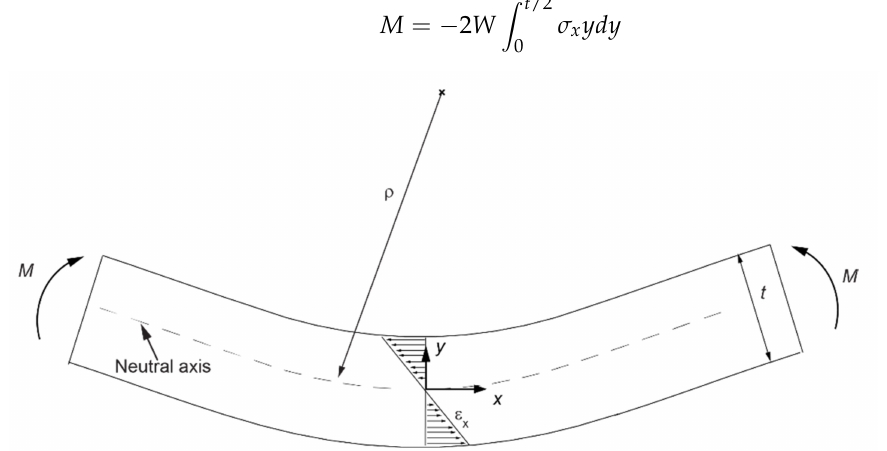
Figure 2. A schematic of a differential element of the